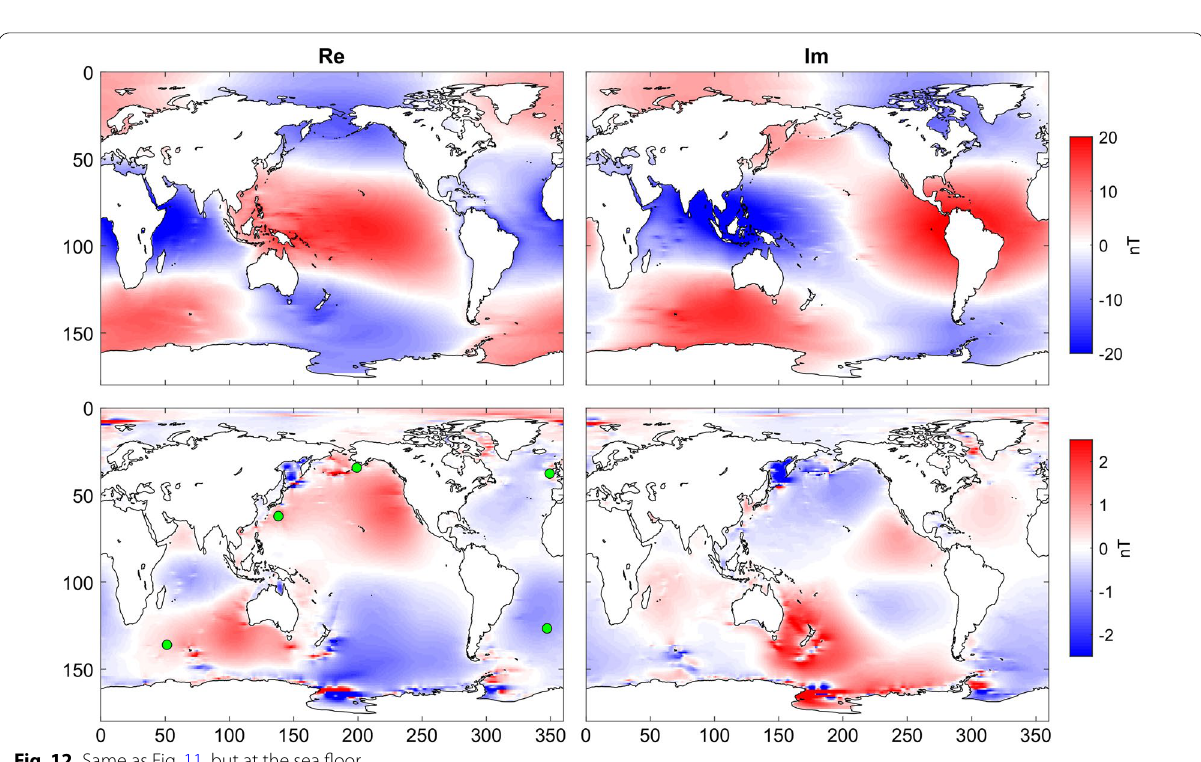
Fig. 12 Same as Fig. 11, but at the sea